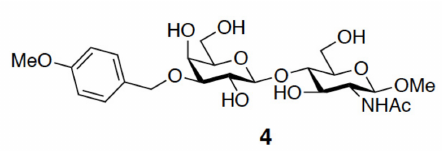
Figure 12. Molecular structure of 3 (cid:48) - O - p -methoxybenzyl ether-substituted LacNAc (compound 4